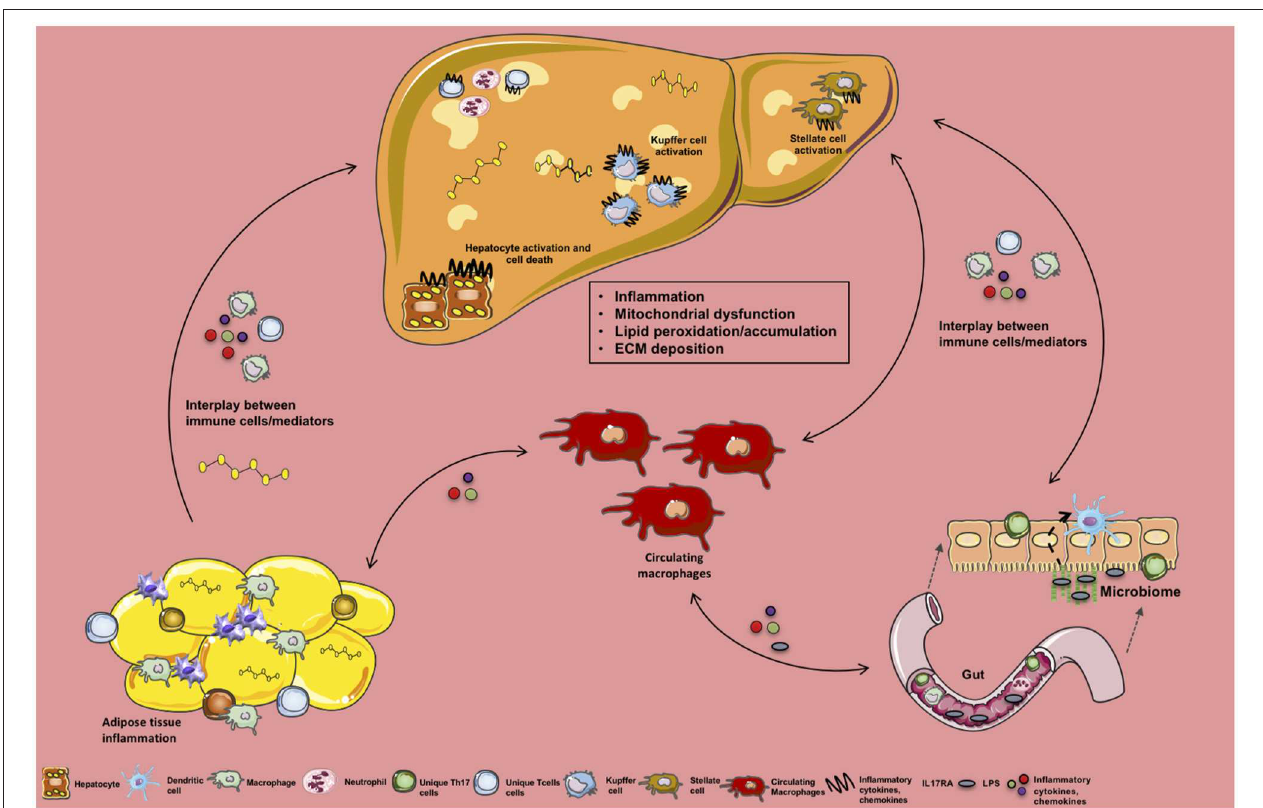
FIGURE 3 | Crosstalk between tissue-specific inflammation and macrophage function in NAFLD. Schematic overview of the crosstalk between various organs, their specific immune cells and inflammatory mediators during NAFLD. Obesity-associated low-grade, chronic inflammation and altered gut microbiome impacts immune cell crosstalk between the gut, circulating monocytes/macrophages, and the liver. In addition, obesity-associated adipocyte expansion promotes hypoxia leading to adipose tissue (AT) inflammation, activation of adipose tissue macropahes (ATMs) and fuels infiltration of various immune cells and inflammatory mediator production (e.g., FFAs, ROS, cytokines, chemokines) to be sensed by circulating macrophages and hepatocytes. Collectively these processes alter hepatocellular lipid metabolism, contributing to steatosis and proinflammatory cytokine (IL-17, TNF, IFN γ , IL-6) and chemokine production (CCL2, CXCL9, CXCL10). Moreover, this inflammatory state activates hepatic stellate cells (HSCs) and Kupffer cells (KCs) in turn contributing to extracellular matrix deposition (collagen fibers) and progression to fibrosis.